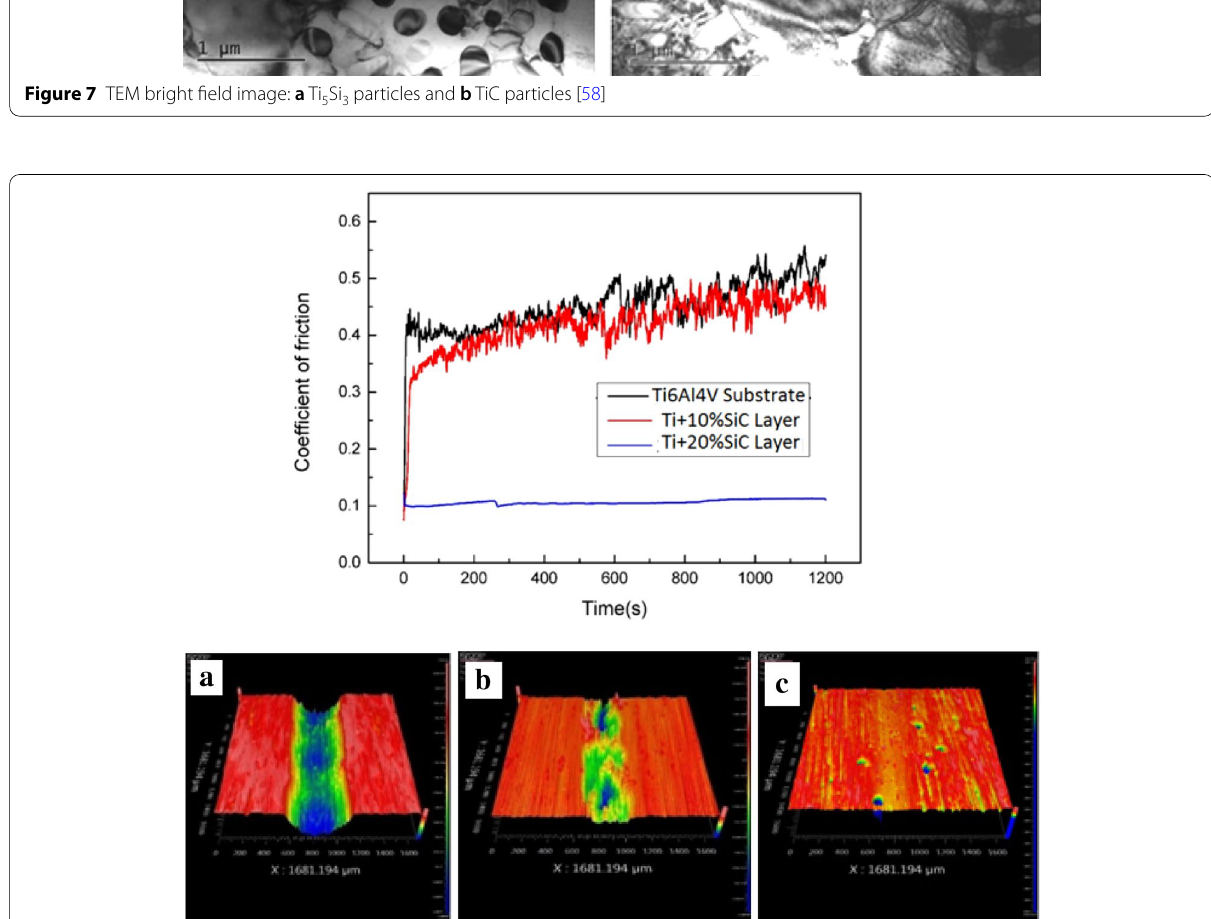
Figure 8 Friction coefficient as a function of time for the two cladded coatings and the Ti6Al4V substrate and Worn surface morphology [58]: a Bare alloy, b 90%Ti 10%SiC layer, c 80%Ti 20%SiC graded + +